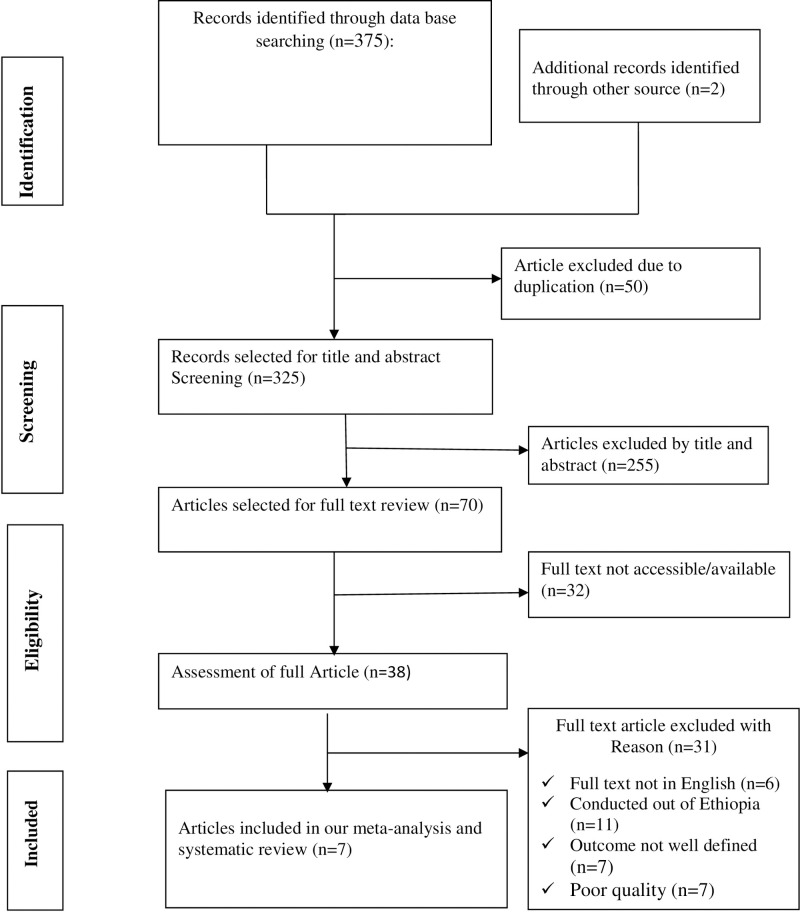
Flow diagram of study selection for systematic review and meta- analysis of adverse birth outcomes and its associated factors among diabetic women in Ethiopia, 2020.